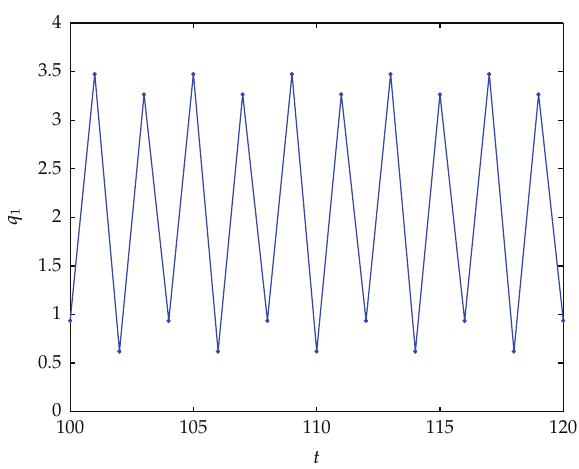
Figure 3: periodic-4 cycle for β (cid:7) 0 . 2 ,α (cid:7) 21 . 0.